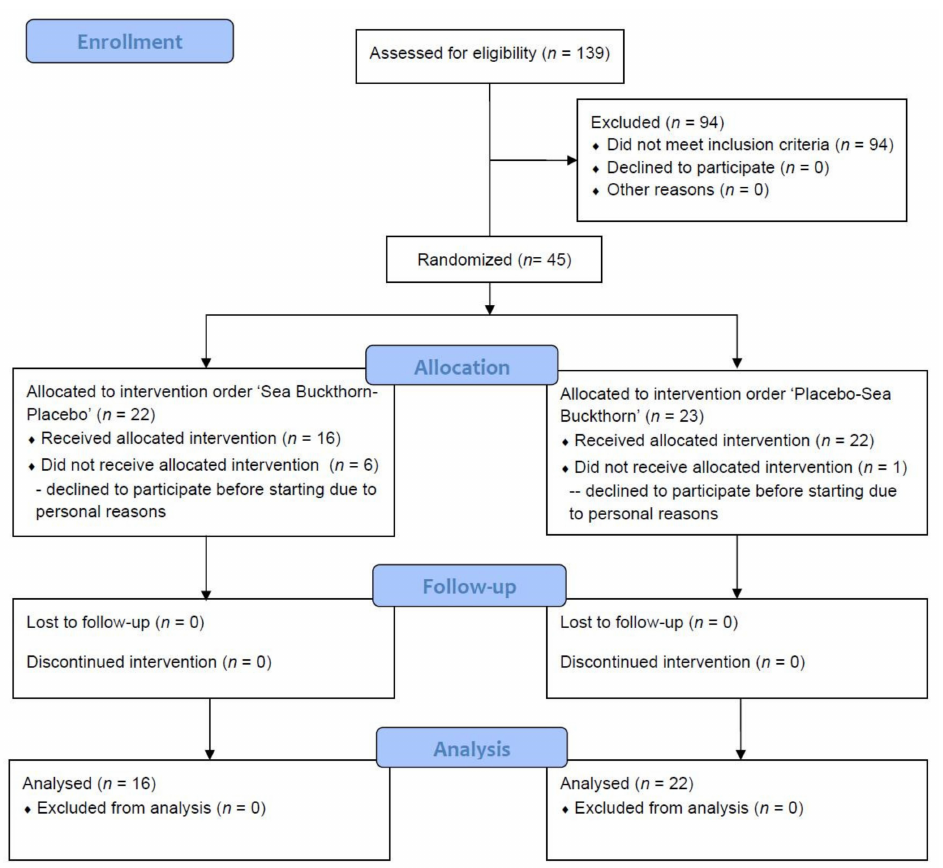
Figure 2. Flow diagram of participation at baseline and